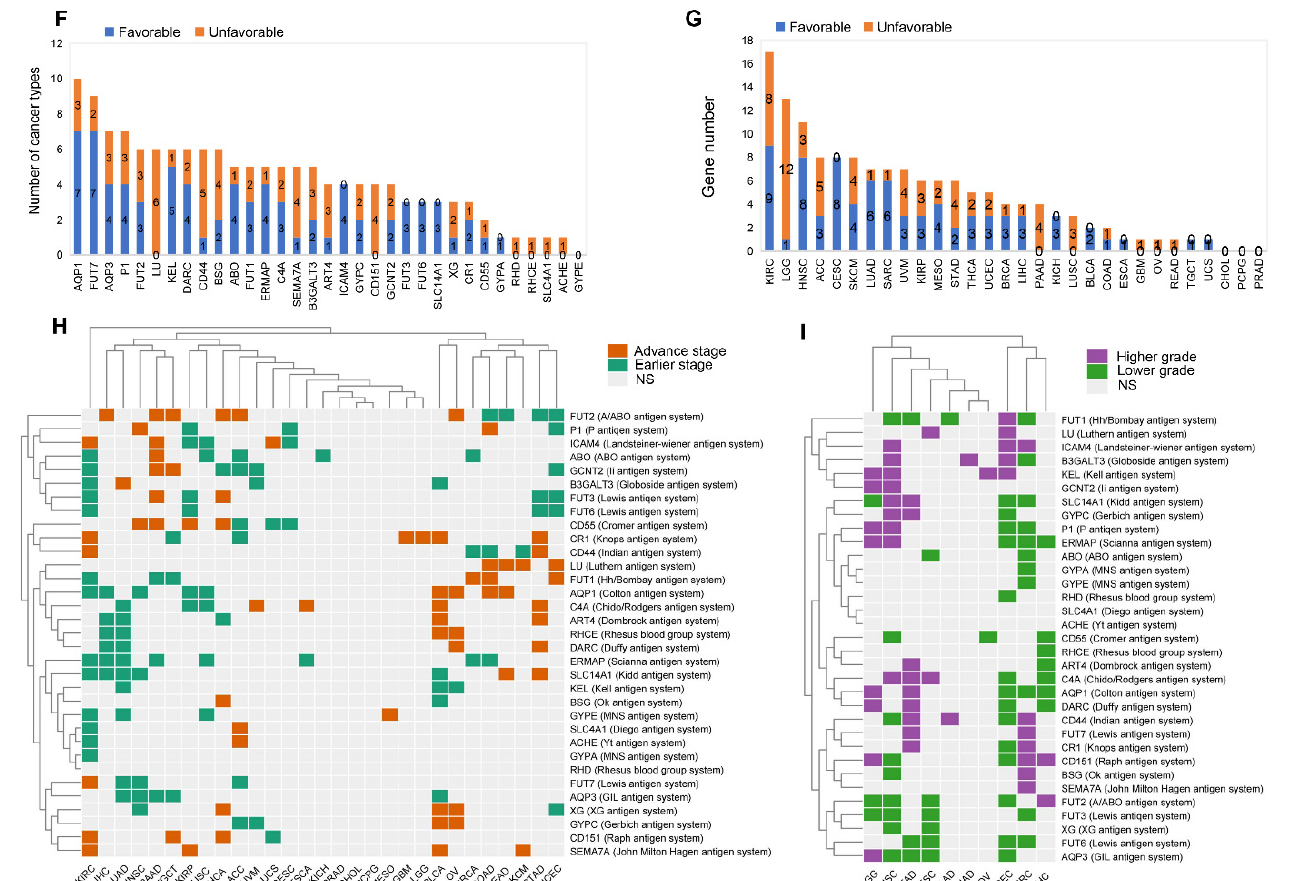
Figure 3. The relationship between the expression of blood group antigen system genes and prognos- tic clinical features in different types of cancers in TCGA dataset. Significant correlation is shown in color ( p < 0.05). ( A ) Association between gene expression and overall survival across human cancers. Unsupervised hierarchical clustering and heatmap for the 33 blood group antigens across 30 cancers based on LOGpc results. Red represents unfavorable outcome (blue represents favorable), i.e., the gene is associated with shorter (or longer) survival. NS: Not Significant. ( B – E ) High AQP1 expression was related to good OS in LUCA and KIRP, to poor OS in LGG and UVM. ( F ) The number of cancer types with prognosis potency. ( G ) The number of each blood group gene in the prognosis of different cancer types. ( H ) Association between gene expression and cancer stage across human can- cers. Earlier/Advance: the gene is associated with earlier/advance stage (Spearman correlation test: p < 0.05). NS: Not Significant. ( I ) Association between gene expression and tumor grade across hu- man cancers. Lower/Higher: the gene is associated with lower/higher grade (Spearman correlation test: p < 0.05). NS: Not Significant. Cancer types: ACC (adrenocortical carcinoma), BLCA (bladder urothelial carcinoma), BRCA (breast invasive carcinoma), CESC (cervical squamous cell carcinoma and endocervical adenocarcinoma), CHOL (cholangiocarcinoma), COAD (colon adenocarcinoma), ESCA (esophageal carcinoma), GBM (glioblastoma multiforme), HNSC (head and neck squamous cell carcinoma), KICH (kidney chromophobe), KIRC (kidney renal clear cell carcinoma), KIRP (kidney re- nal papillary cell carcinoma), LGG (brain lower grade glioma), LIHC (liver hepatocellular carcinoma), LUAD (lung adenocarcinoma), LUSC (lung squamous cell carcinoma), MESO (mesothelioma), OV (ovarian serous cystadenocarcinoma), PAAD (pancreatic adenocarcinoma), PCPG (pheochromocy- toma and paraganglioma), PRAD (prostate adenocarcinoma), READ (rectum adenocarcinoma), SARC (sarcoma), SKCM (skin cutaneous melanoma), STAD (stomach adenocarcinoma), TGCT (testicular germ cell tumors), THCA (thyroid carcinoma), UCEC (uterine corpus endometrial carcinoma), UCS (uterine carcinosarcoma), and UVM (uveal